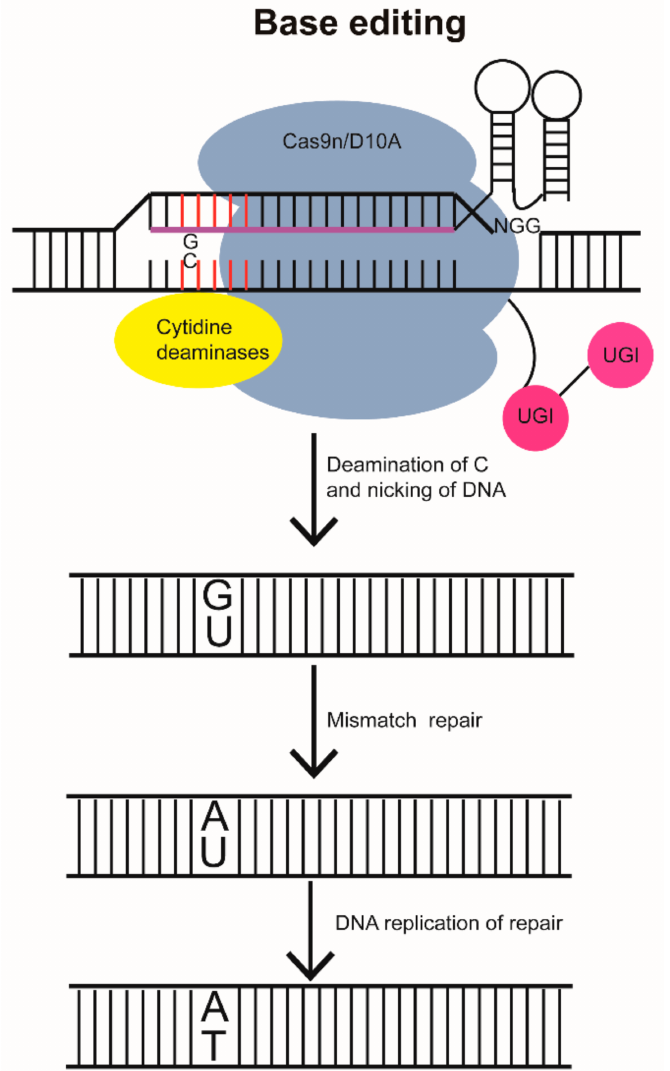
Figure 4. Base editing (BE) technology. Cytosine base editors consist of a deaminase and uracil glycosylase inhibitor (UGI) fused with the N and C terminus of D10A Cas9n, respectively. Deaminase can convert cytosine into uracil to produce a U:G wobble. UGI prevents the conversion of U back to C. U:A is formed during mismatch repair and is then converted to T:A through replication, thus completing the C:G to T:A